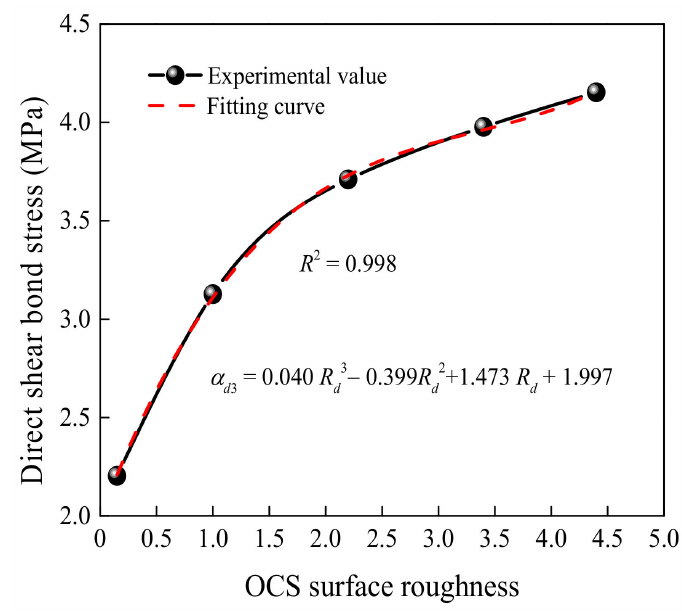
Figure 11. Effect of the OCS surface roughness on shear bond stress.